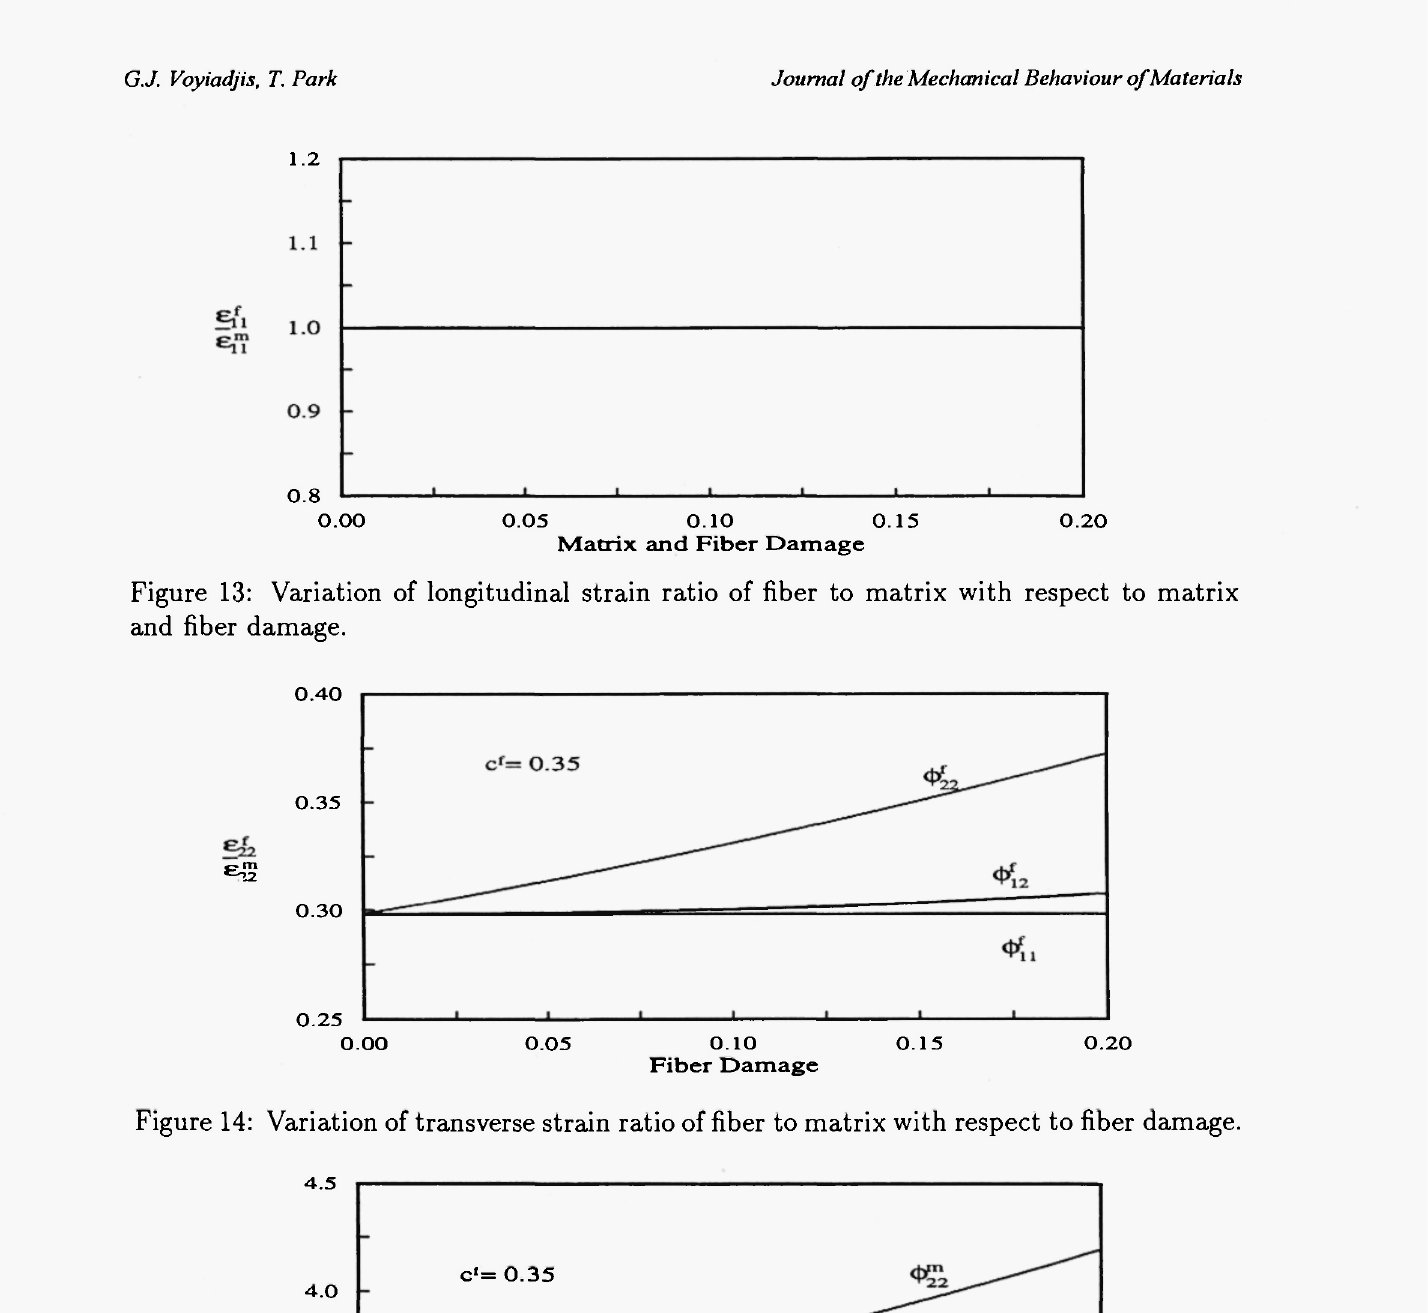
Figure 15: Variation of transverse strain ratio of fiber to matrix with respect to matrix